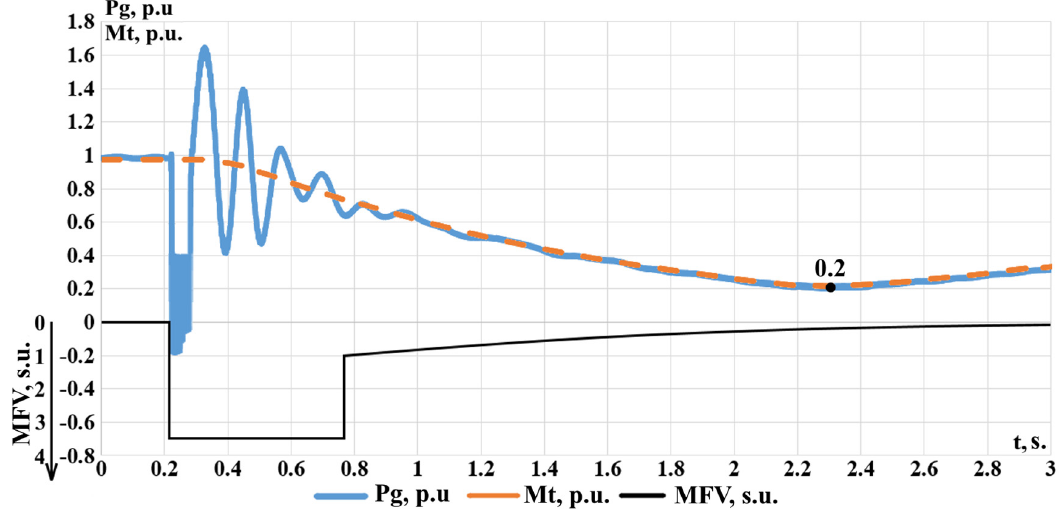
Figure 17. Generator G 2 active power and turbine torque for a case of FV ( A i = 3.5 pu, T MFV = 0.55 s).